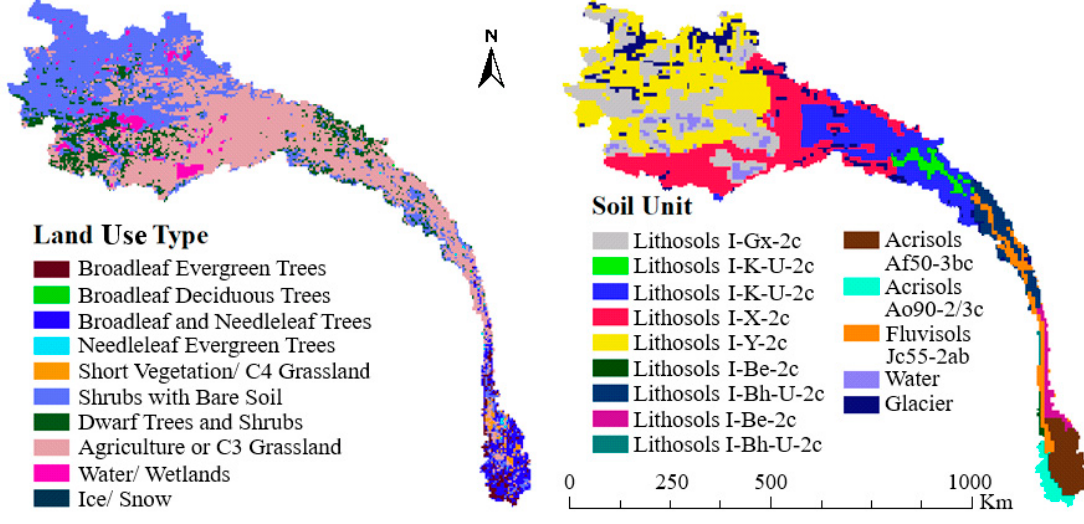
Figure 2. Land use and soil types in the Nujiang River